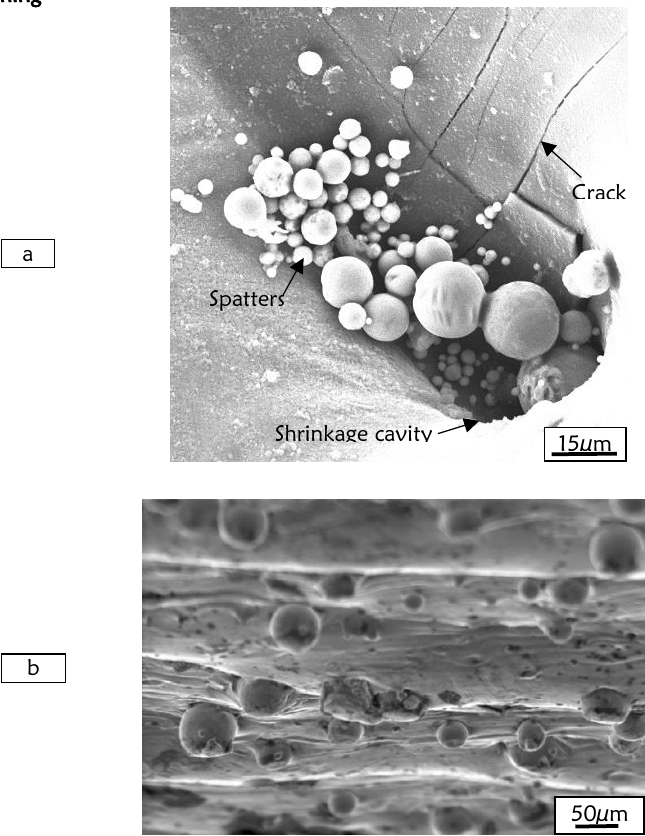
Figure 22. Typical defects found on SLM IN718 surfaces: (a) unmelted particles and spatters, shrinkage cavity, micro microcrack on the X-Y plane (b) rough surface due to partially melted powder and imperfect layer bonding when viewing along the